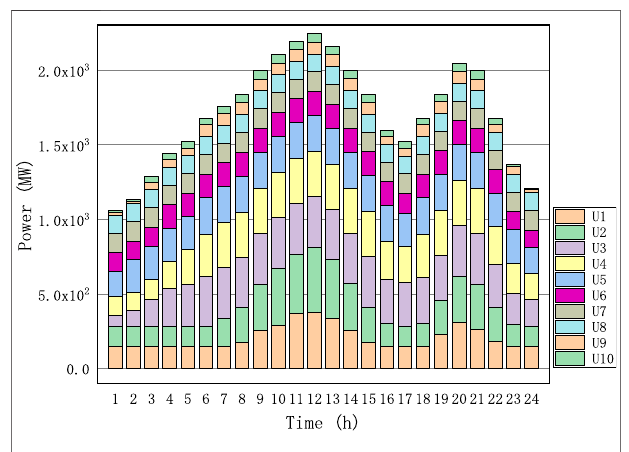
FIGURE 4 | The power output of the only 10-unit power